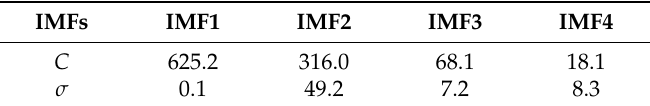
Table 2. Least squares support vector machine (LSSVM) model parameters of IMFs for Shangjingyou station. C : penalty factor; σ : parameter of kernel function. IMFs IMF1 IMF2 IMF3 IMF4 C 625.2 316.0 68.1 18.1 σ 0.1 49.2 7.2 8.3